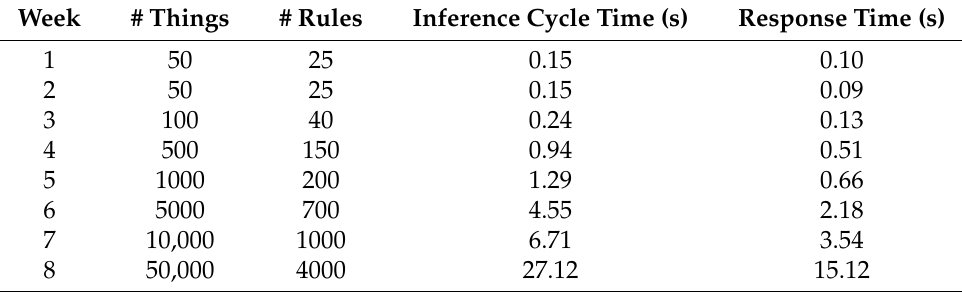
Table 6. Performance results.